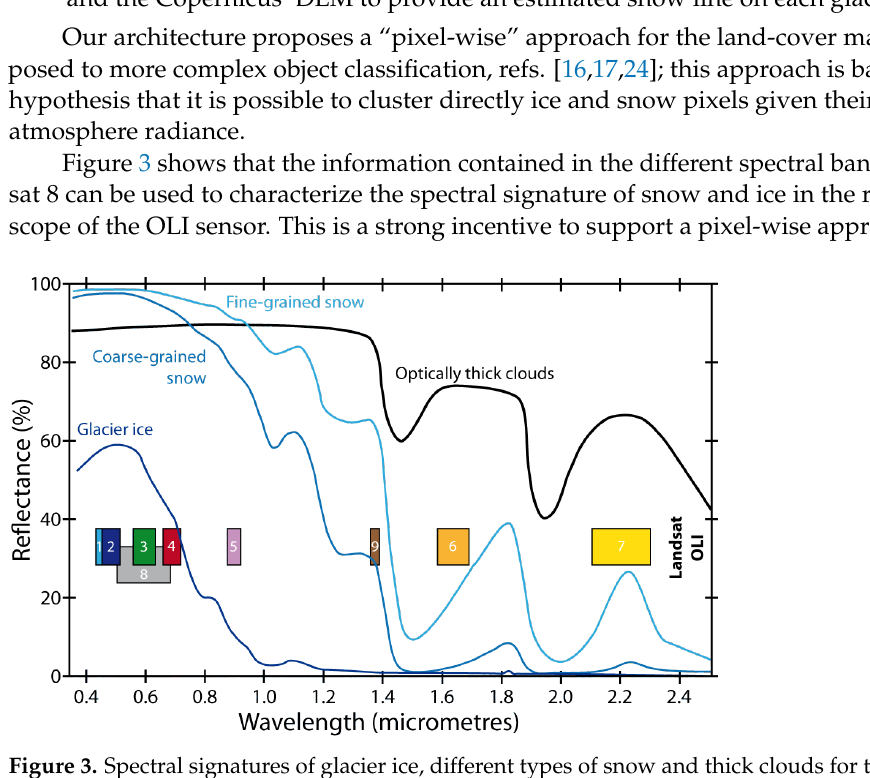
Figure 3. Spectral signatures of glacier ice, different types of snow and thick clouds for the optical to shortwave infrared domain, adapted from [16]. Each box represents the spectral range covered by each band of the Landsat 8 OLI, and the boxes number refers to the band number of the